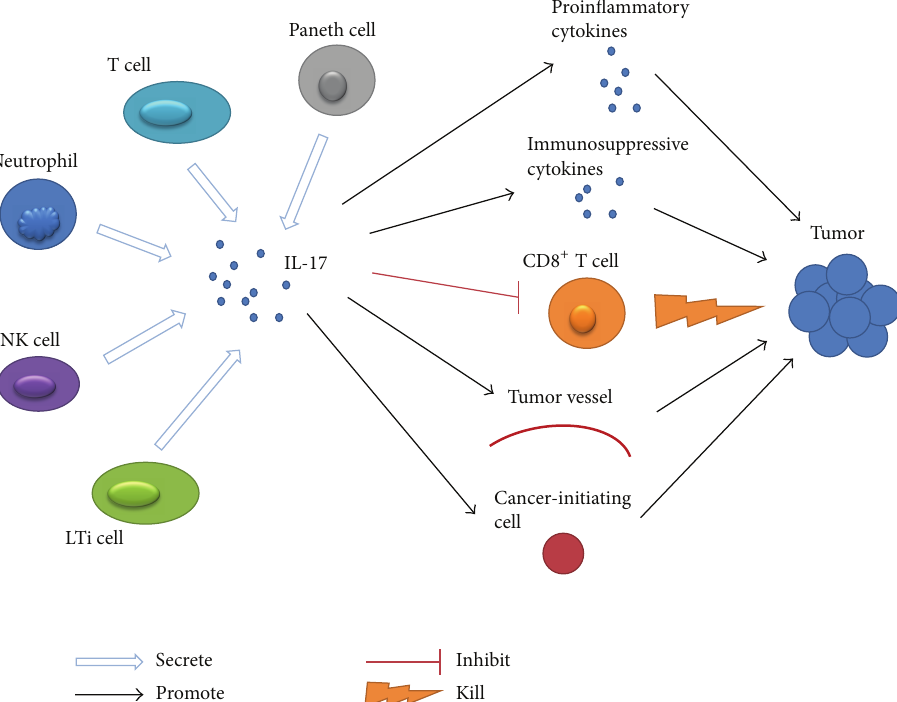
Figure 1: This is an illustration about the protumor activity of IL-17 in CRC microenvironment. Blue colored arrow shows cells producing IL-17. Black arrow shows the latter stimulated by the former. T-shaped arrow shows process inhibited by IL-17 and lightning arrow shows attack on tumor